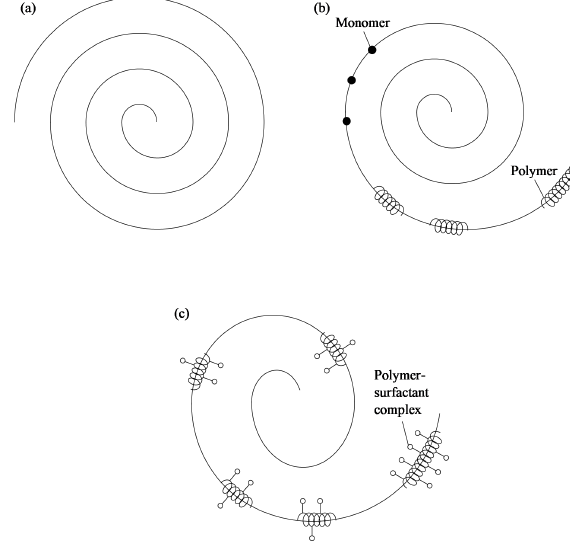
Figure 10: Possible drag reduction mechanism (a) turbulence struc- ture, (b) interaction of polymer molecules and (c) interaction